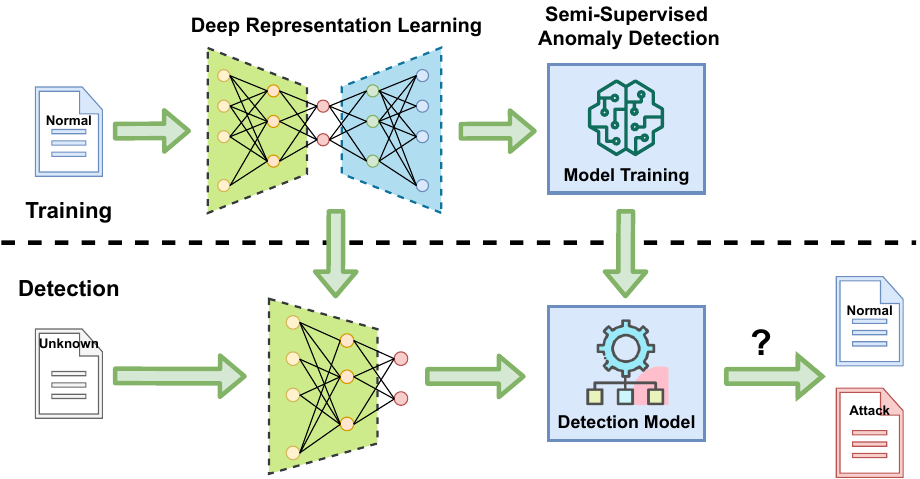
Figure 4. Proposed method to detect cyber attacks in smart grids with semi-supervised anomaly detection and deep representation